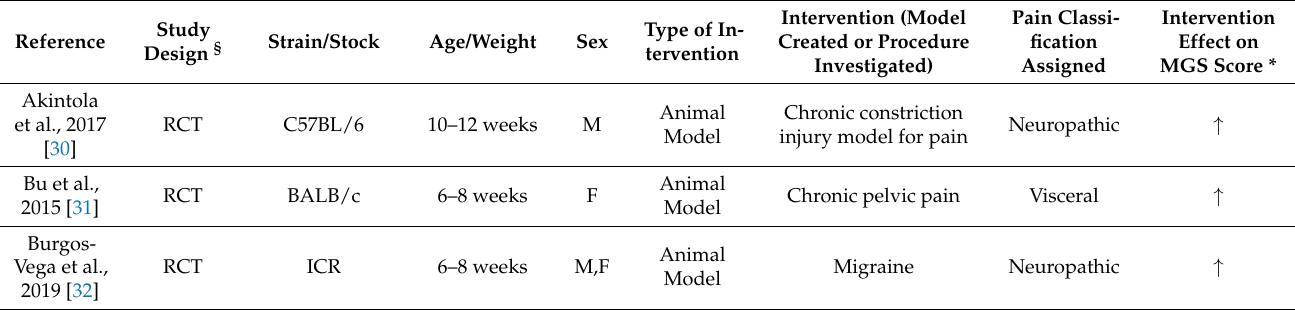
Figure 1. The PRISMA [29] flow diagram for the review detailing the database searches, the number of abstracts screened, and the full texts retrieved. Table 1. List of included